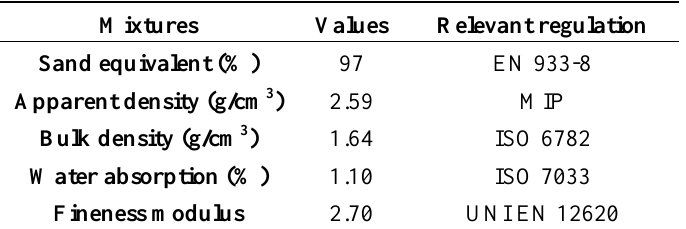
Table 3. Physical characteristics of siliceous